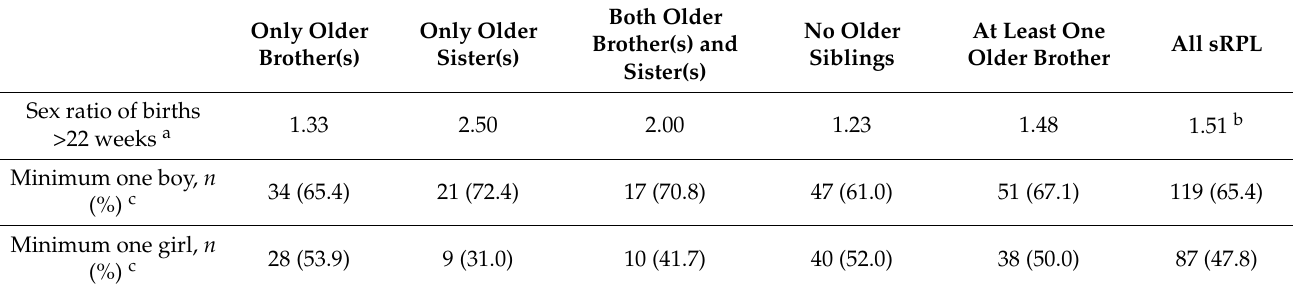
Table 4. Sex ratio of the firstborn child in sRPL patients stratified according to sex of RPL patient’s older siblings.